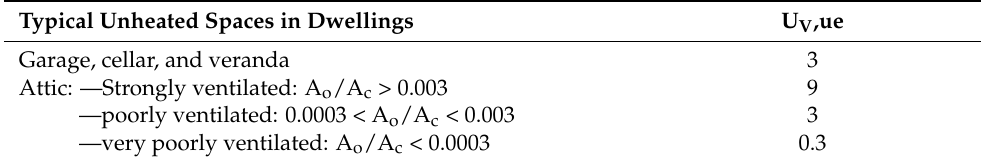
Table 11. Default values of the coefficient U V ,ue for dwellings (adapted from [16]). Typical Unheated Spaces in Dwellings Garage, cellar, and veranda